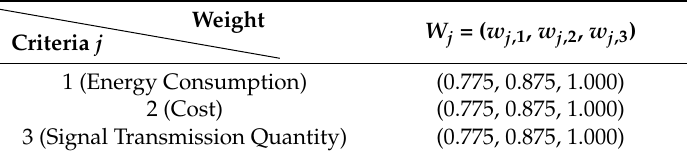
Table 3. Triangular fuzzy weights of the three criteria.